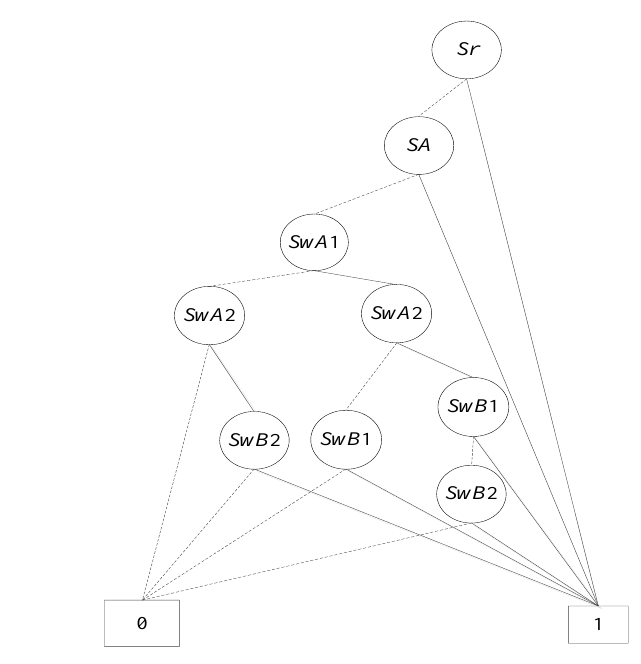
Figure 4. BDD model of the example mesh SAN.